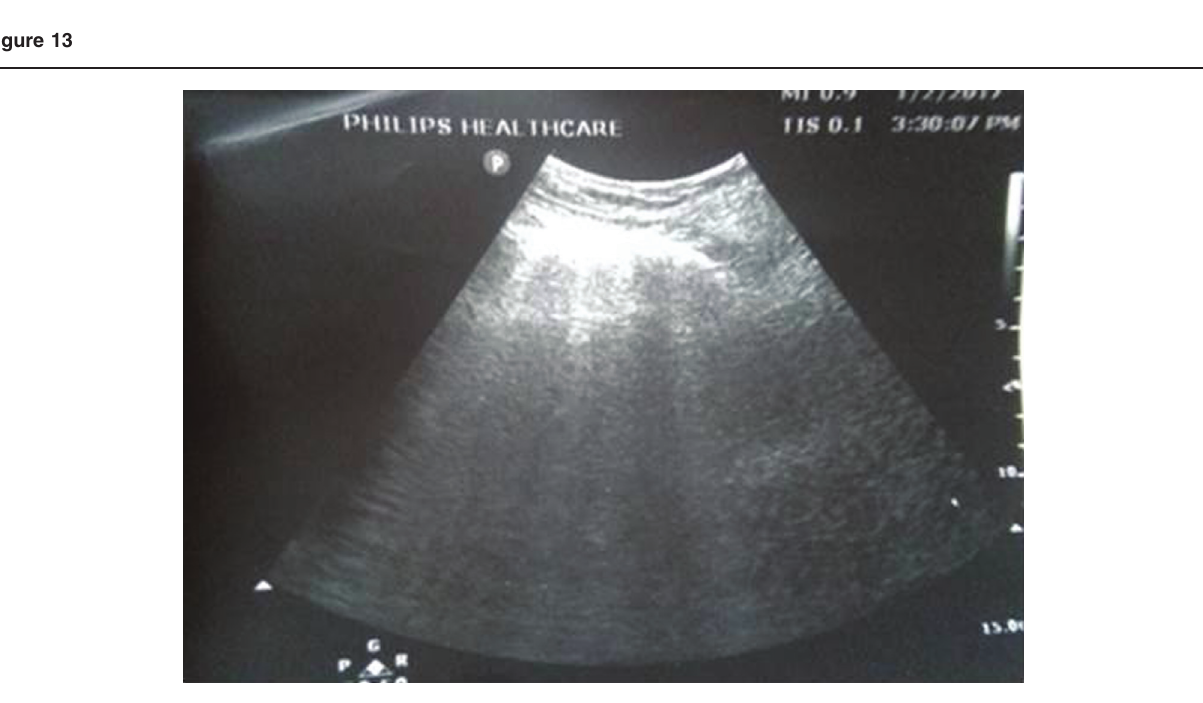
Ultrasound of a patient with severe restriction (wide distance between B-lines).